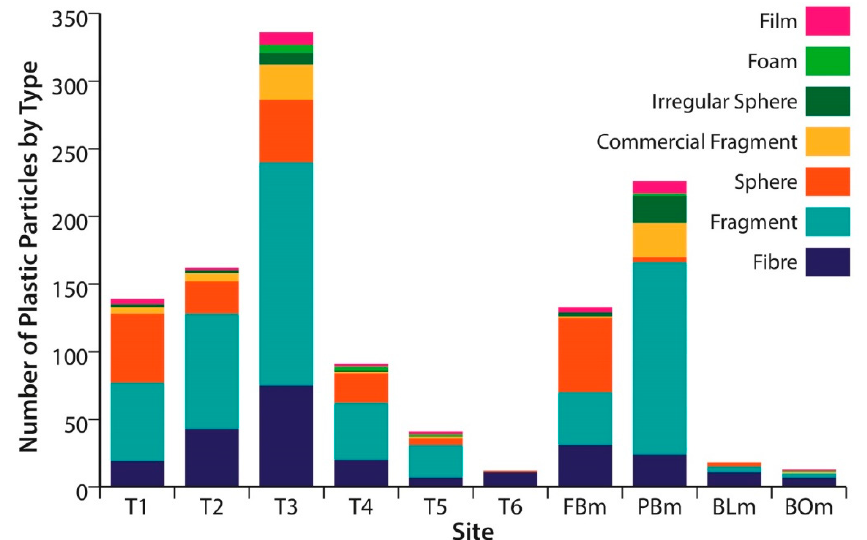
Figure 3. Distribution of plastic particles by shape at each sampling location, see Figure 1 for location of sites.